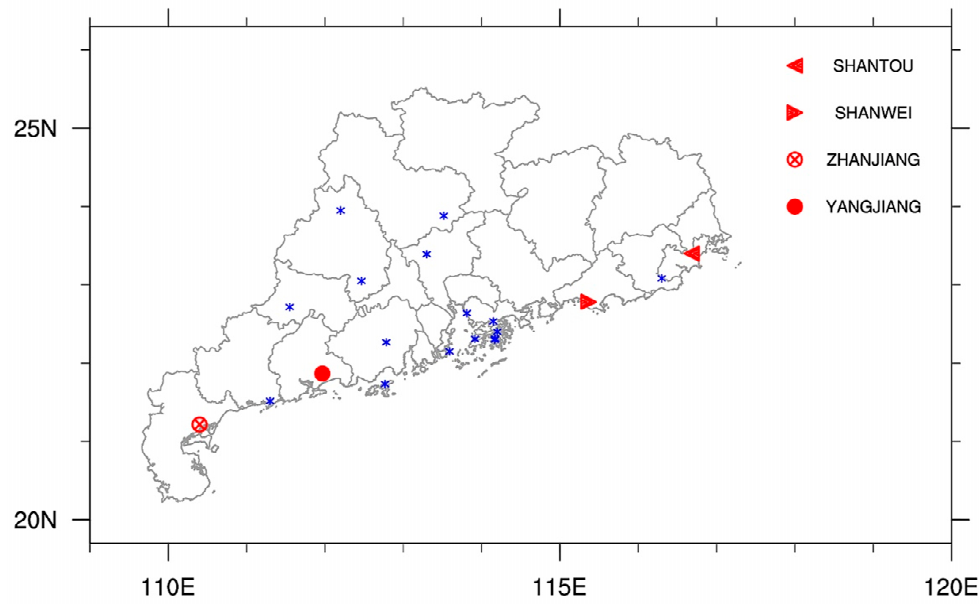
Figure 3. Location of selected stations in Guangdong, Hong Kong, and Macau in blue stars (data period, station ID, and exact positions are given in Table 1). The stations, which are selected for the analysis in Section 3.1 is shown in red (see legend).